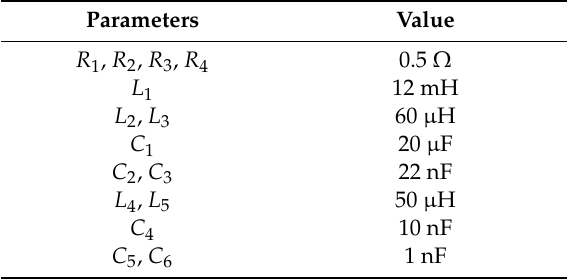
Table 2. Parameters used in the decoupling network as well as module and line impedances.